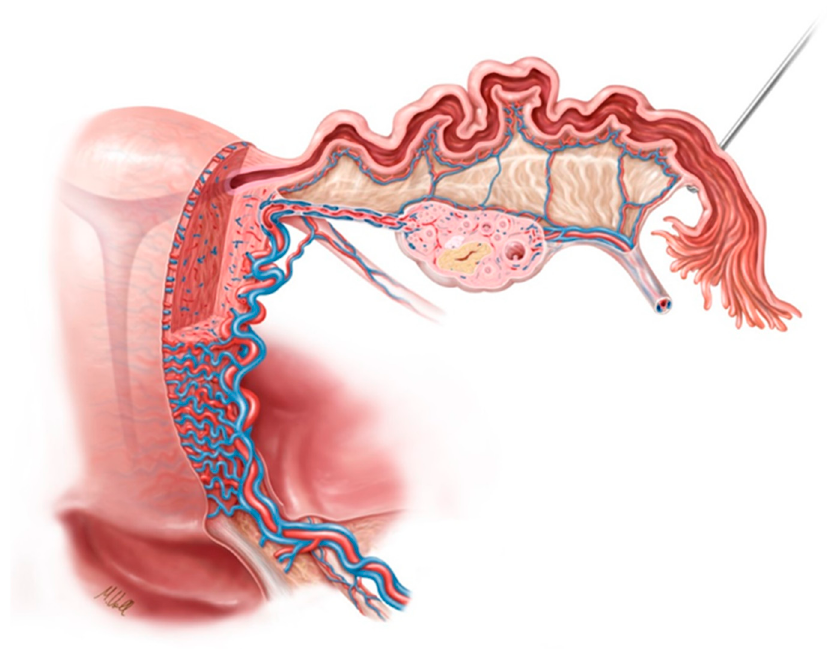
Figure 1. Anatomy of the fallopian tube with arterial and venous blood